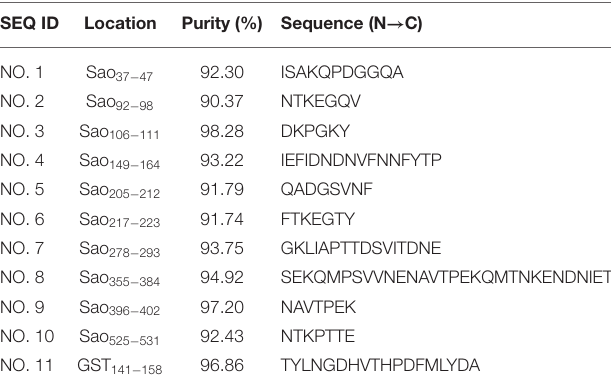
TABLE 1 | Amino acid sequence of 10 candidate B-cell epitopes of Sao-M protein.